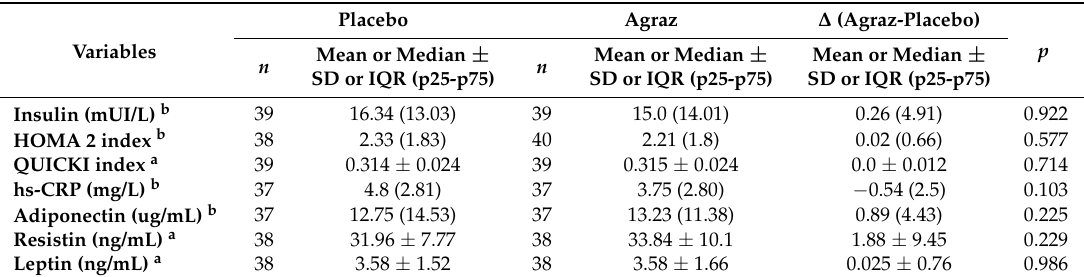
Table 3. Changes in antioxidant capacity and oxidation markers in women with metabolic syndrome after agraz consumption compared to placebo.